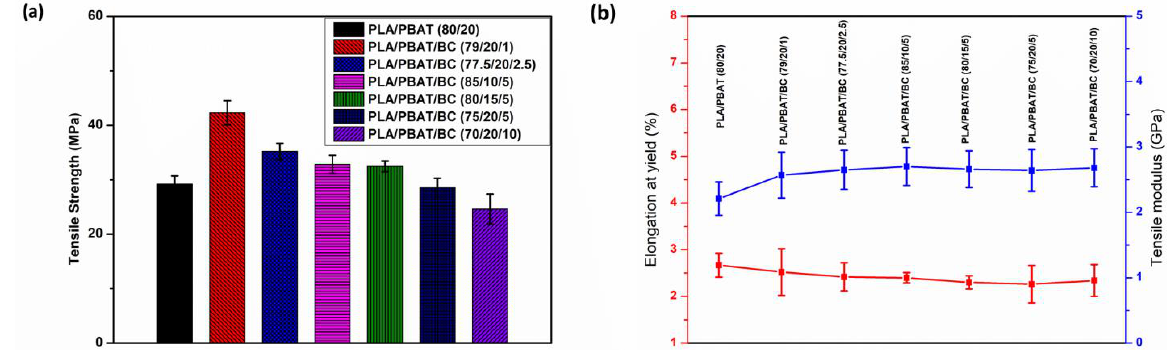
Figure 10. ( a ) tensile strength, ( b ) tensile modulus and elongation at yield of the composites.